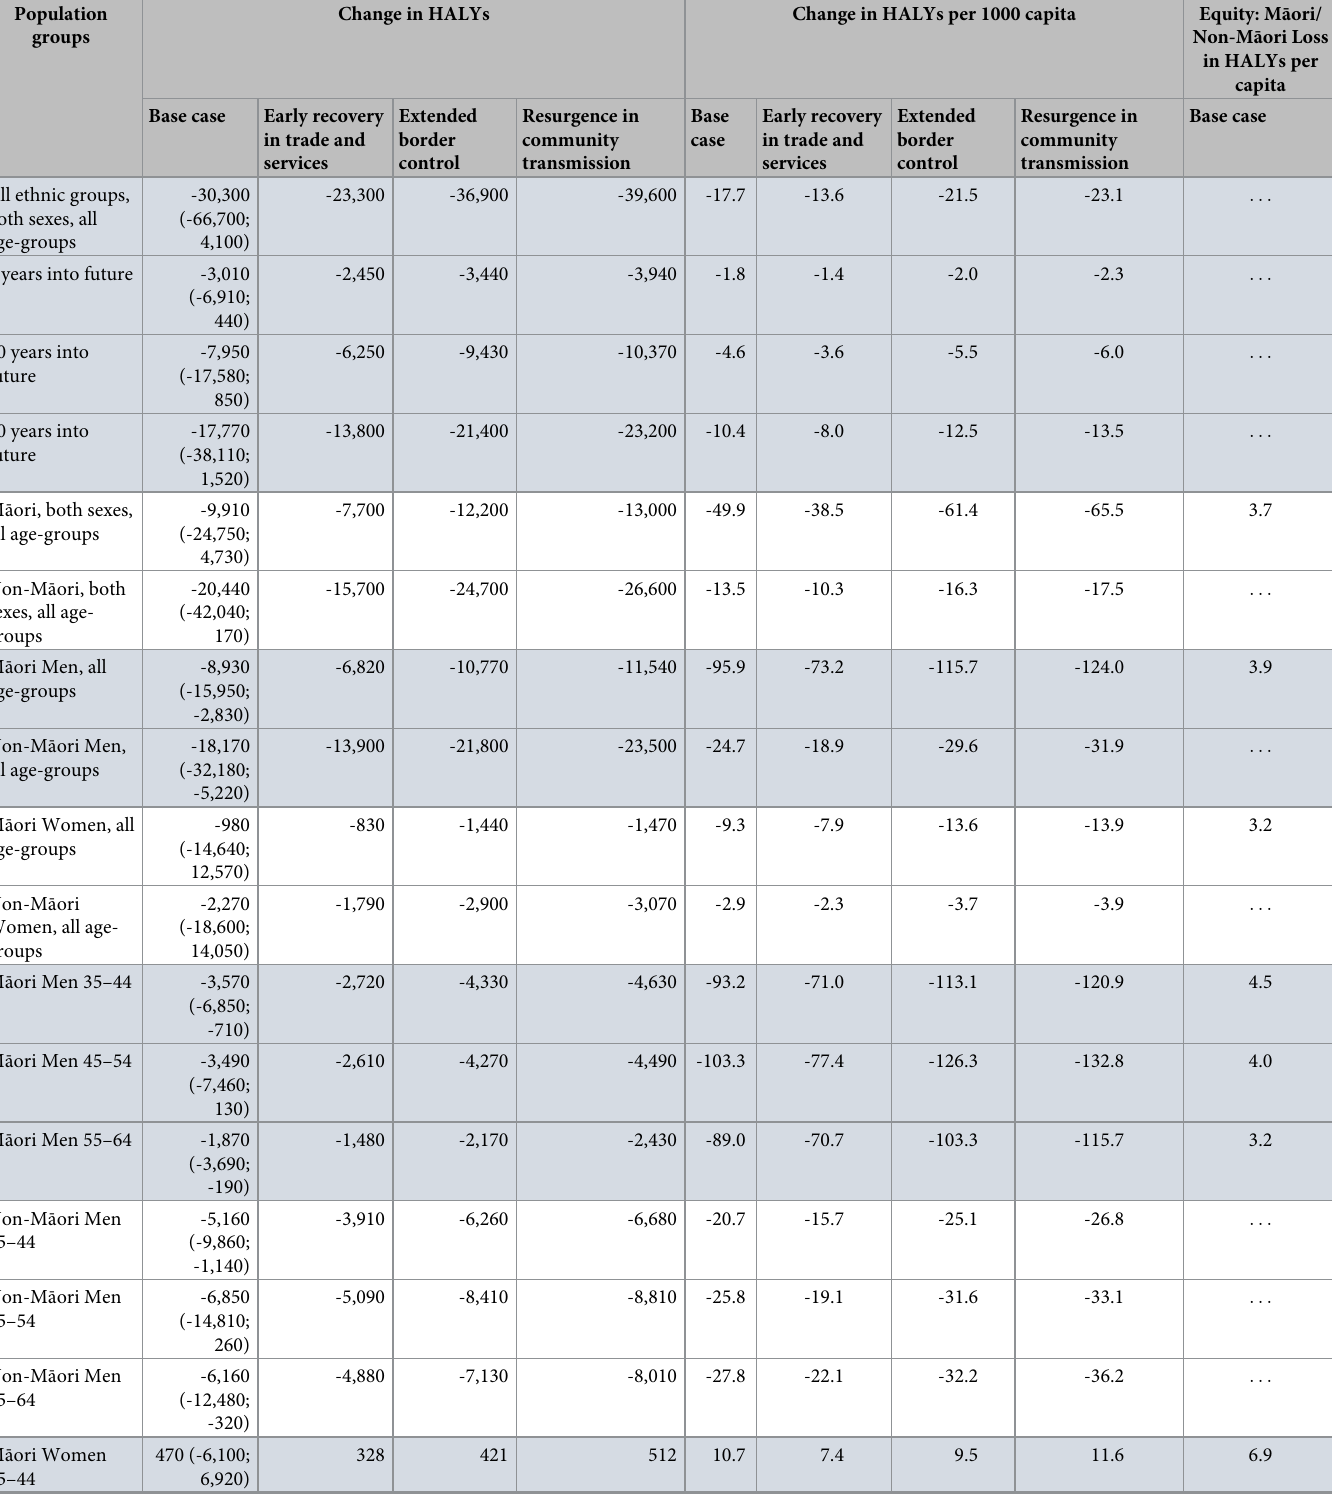
Table 4. Health loss (in HALYs) results for the base case (most likely unemployment scenario) (3% discount rate for the remaining life of the NZ population alive in 2011) for various COVID-19 pandemic-induced unemployment scenarios from the NZ Treasury. Population